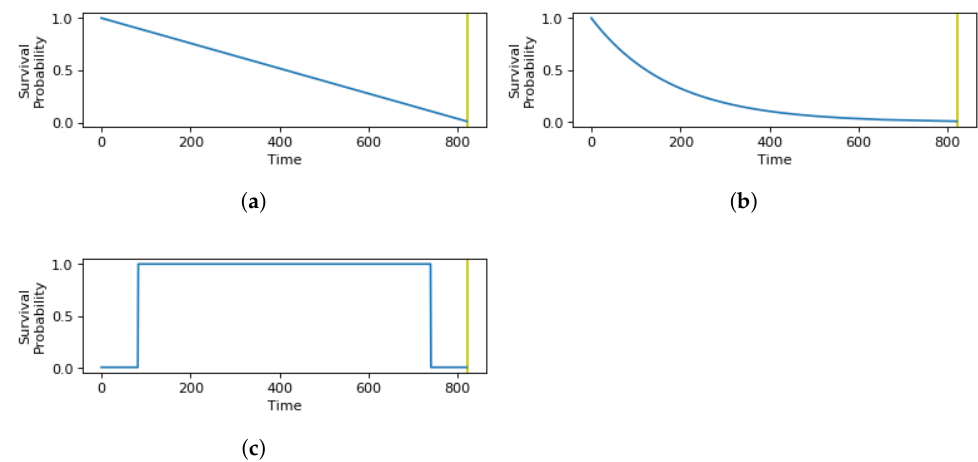
Figure 6. Illustration of the survival probability using the ( a ) linear function, ( b ) exponential function, ( c ) uniform function.